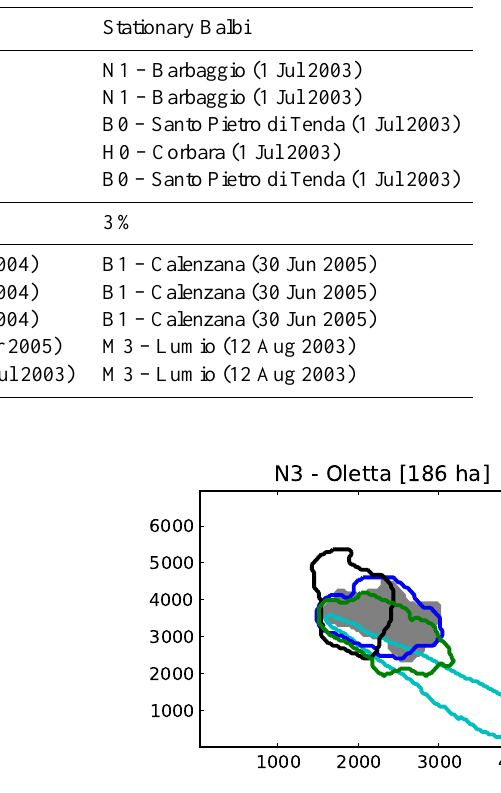
Figure 4. Case of the Oletta fire (21 August 2004; N3 in the Ap- Figure 3. Case of the Ghisonaccia fire (20 August 2003; C2 in the Fig. 4. Case of Oletta fire (2004-08-21, N3 in appendix) as observed (burned area in grey) and pendix) as observed (burned area in grey) and simulated by the non- Appendix) as observed (burned area in grey) and simulated by the simulated by the non-stationary Balbi model (blue), the stationary Balbi model (green), the Rothermel stationary Balbi model (blue), the stationary Balbi model (green), Rothermel model with raw automatic (black) and corrected (red) model (black) and the 3-percent model (cyan). the Rothermel model (black) and the 3% model parameters. Coloured dots correspond to the ignition points.